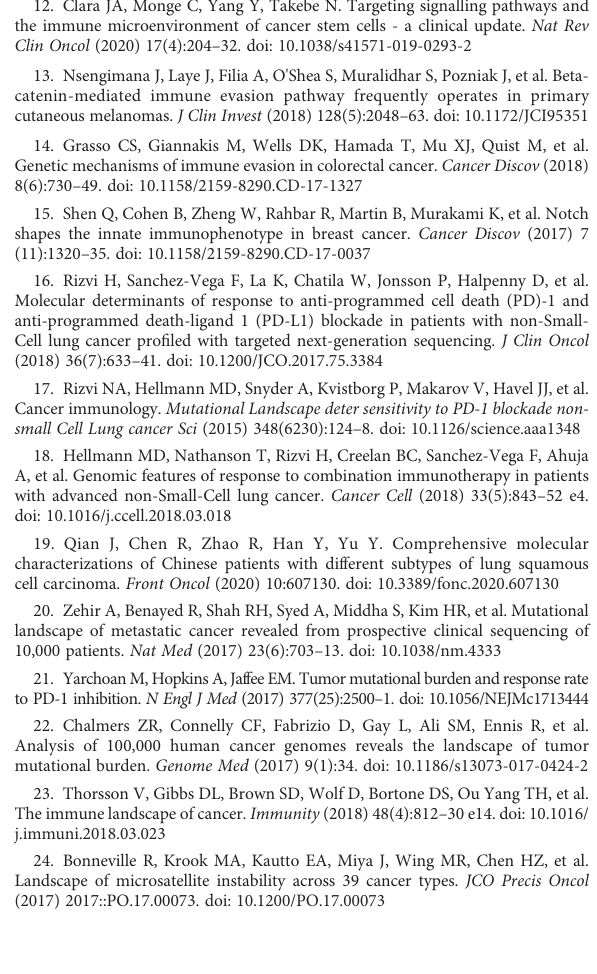
SUPPLEMENTARY TABLE 9 Differential GSVA score between SMO_MUT and SMO_WT tumors in TCGA pan-cancers. ( p <0.05 were